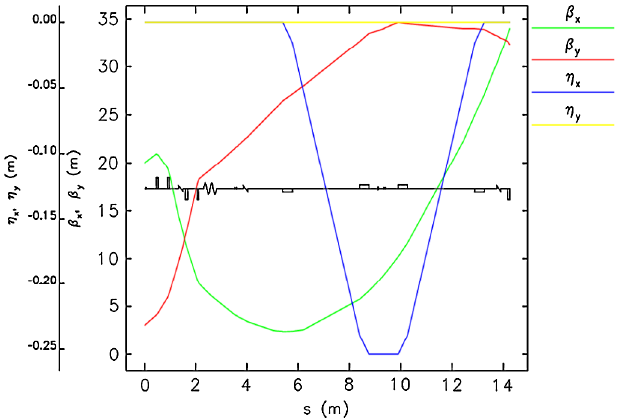
FIG. 4. Some quadrupoles downstream of BC1 are used in the ELEGANT matching procedure to match the beam optics to the design values. In this plot, the optical functions are transported in the common forward mode from the end point of Fig. 3 (entrance of BC1) to the end of the BC1 diagnostic area. The matching loop performed by ELEGANT finds a good solution after one iteration (a low- (cid:4) symmetric optics after BC1 reflects the design optics). The theoretical mismatch parameters in this case are ¼ 1 : 002 , (cid:3) ¼ 1 : 005 . The black line in the middle sketches (cid:3) x y the machine